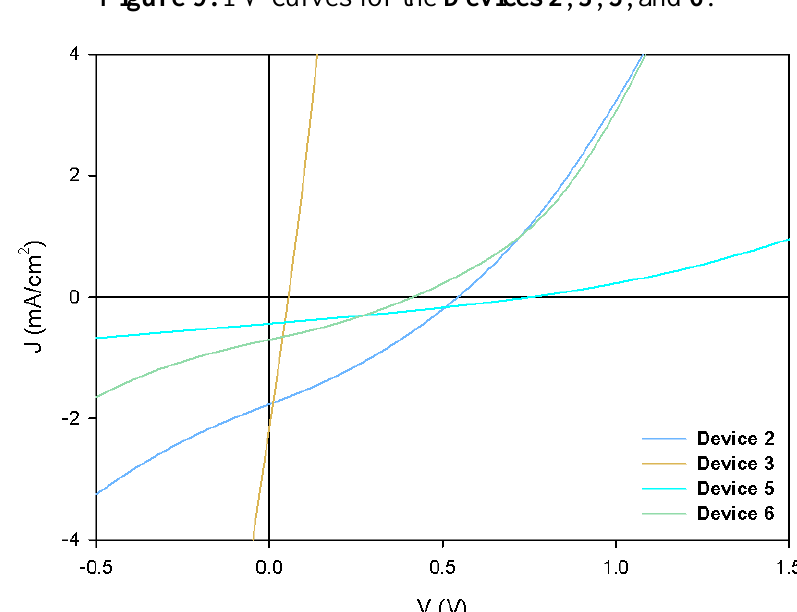
Figure 9. I-V curves for the Devices 2 , 3 , 5 , and 6